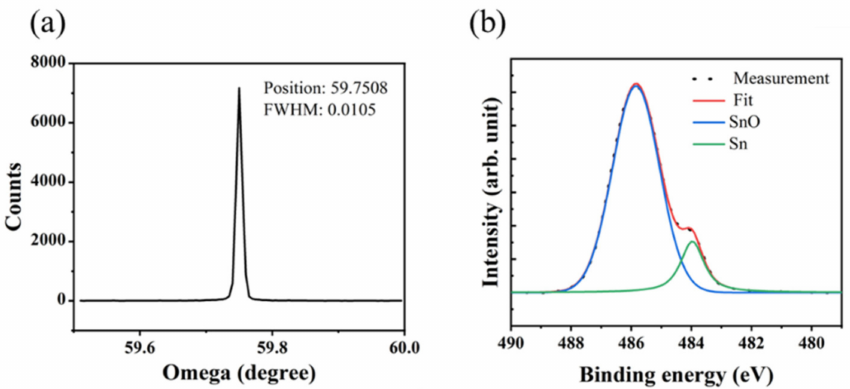
Figure 2. ( a ) XRD results of H-diamond, ( b ) Sn 3d photoelectron spectra for thermal oxidation of